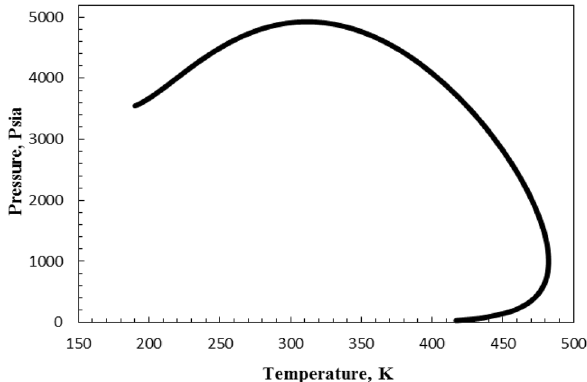
Fig. 1 Phase diagram of reservoir fluid